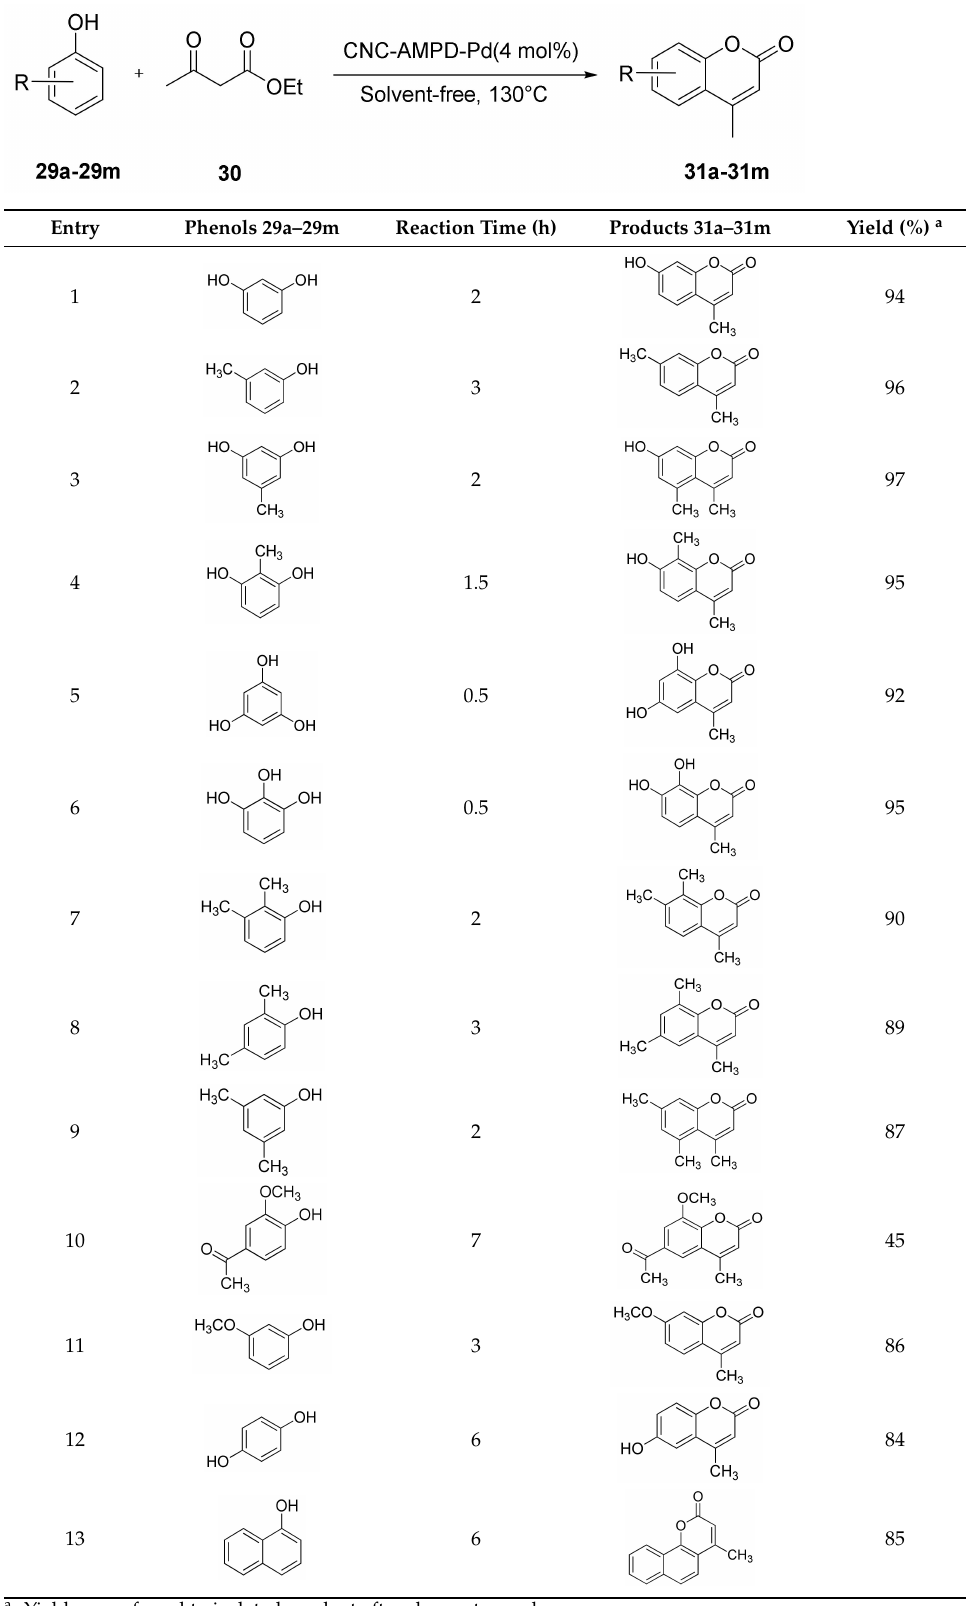
Table 4. Pechman condensation of substituted phenols 29a–29m with ethylacetoacetate 30